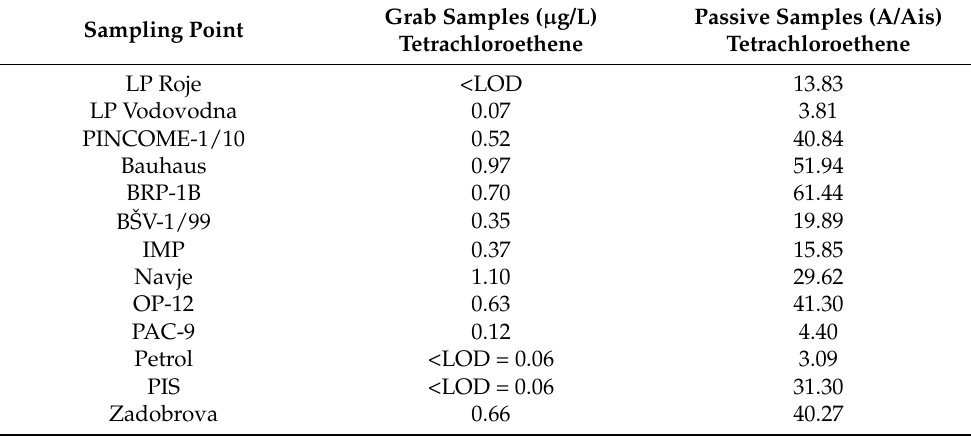
Table 6. Comparison of grab and passive samples in the Ljubljansko polje aquifer. Grab Samples ( µ Sampling Point